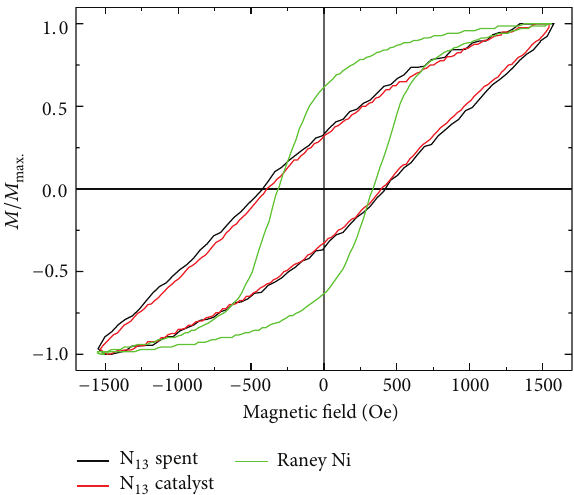
Figure 1: XRD pattern of nano Ni catalyst. ∗ = NiO, # = Ni.